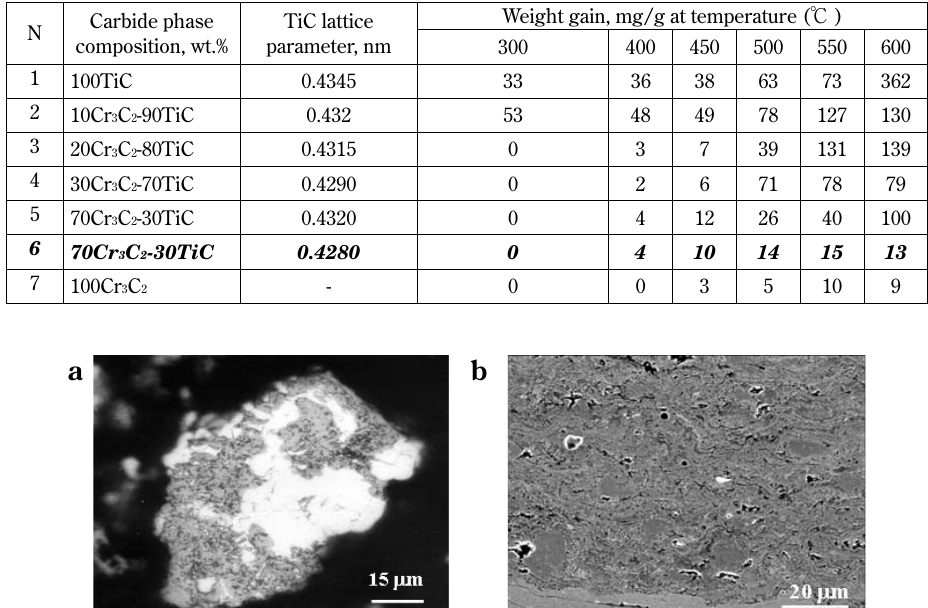
Table 3 Wight gain of the SHS powders 75(Cr 3 C 2 -TiC)/ 25 Ni20Cr, wt.%, with particle size less than 50 µm during oxidation in air Carbide phase N composition,